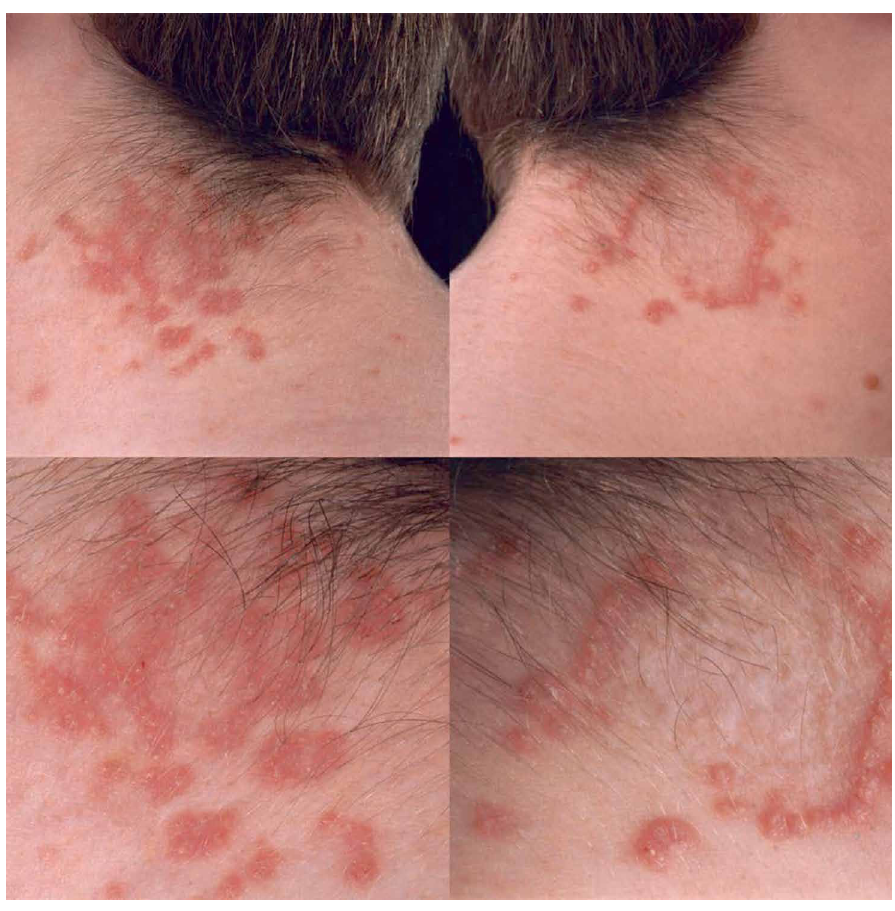
Figure 1: Lesions on left & right neck before treatment.